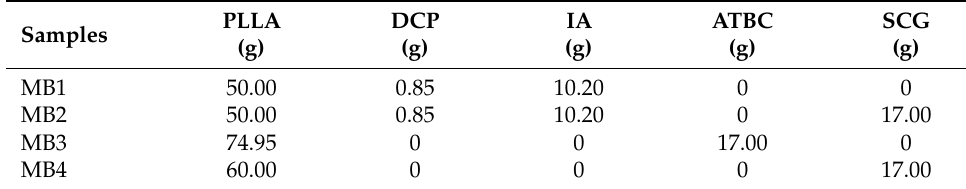
Table 1. Masterbatch compositions.